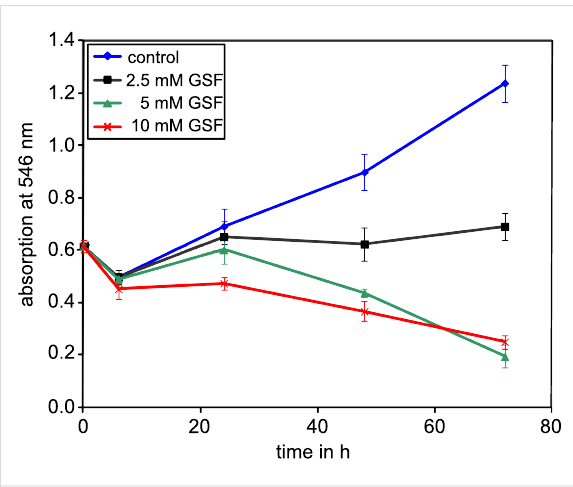
Figure 1: Effects of increasing concentrations of (4-{[( β -D-galactopyra- nosyl)oxy]methyl}furan-3-yl)methyl hydrogen sulfate (GSF) upon the growth of human melanoma cells WM-115. Cell densities were measured by staining adherent and fixed cells with sulforhodamine-B and solubilizing the dye with Tris base. Absorbance was determined at 546 nm. Absorbance values are proportional to cell numbers.